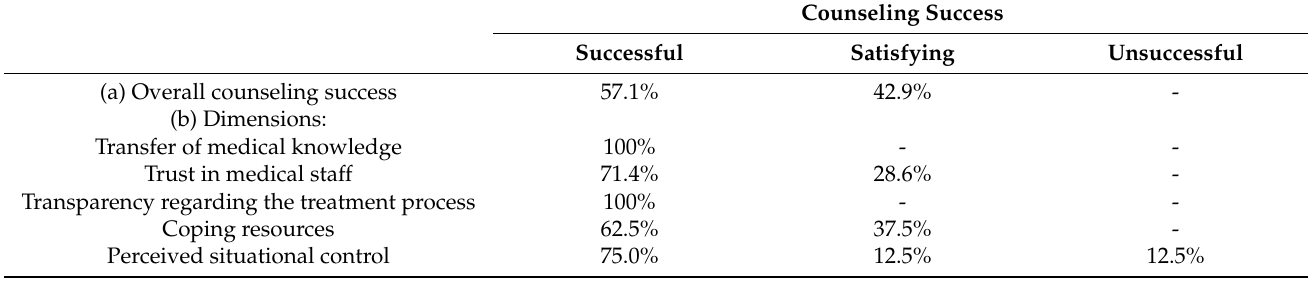
Table 5. Counseling success (COVID-subgroup only) in parents with another native language than the language counseling was conducted in (counseling via interpreters not included).